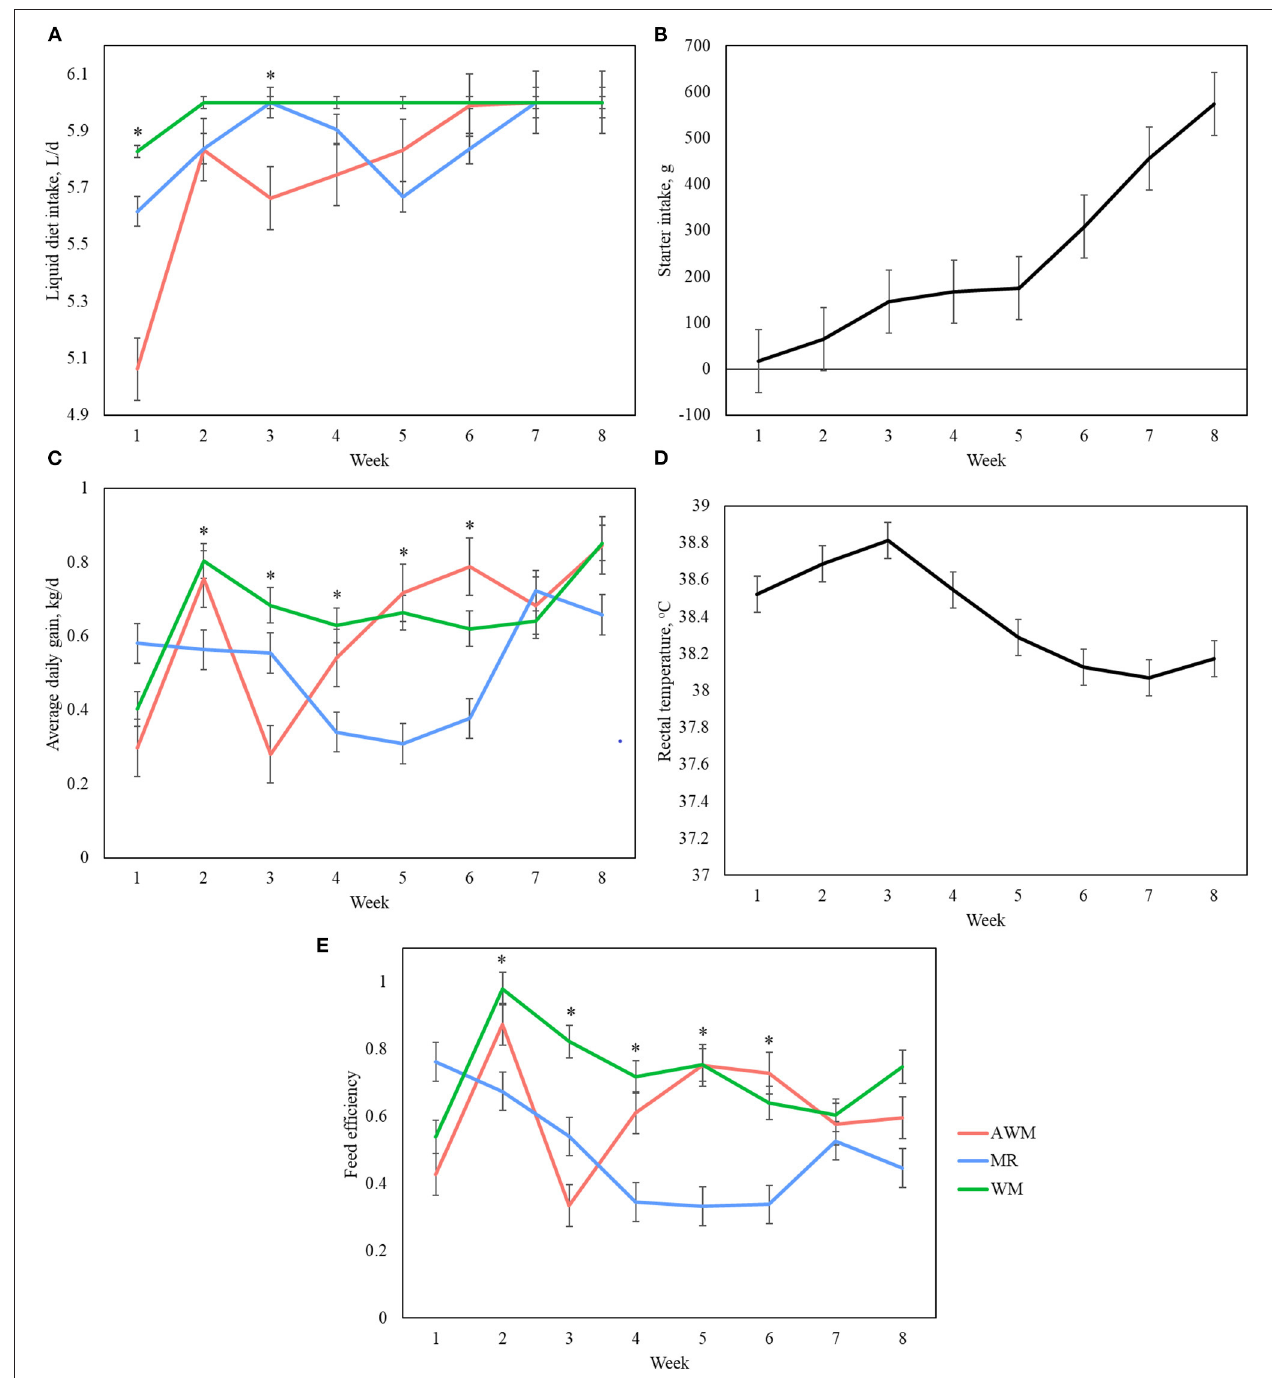
FIGURE 1 | Liquid diet (A) starter intake (B) average daily gain (C) rectal temperature (D) and feed efficiency (E) of dairy calves fed different liquid diets. AWM, Acidified whole milk; MR, Milk replacer; WM, Whole Milk. *Denotes difference among treatments in the respective week.